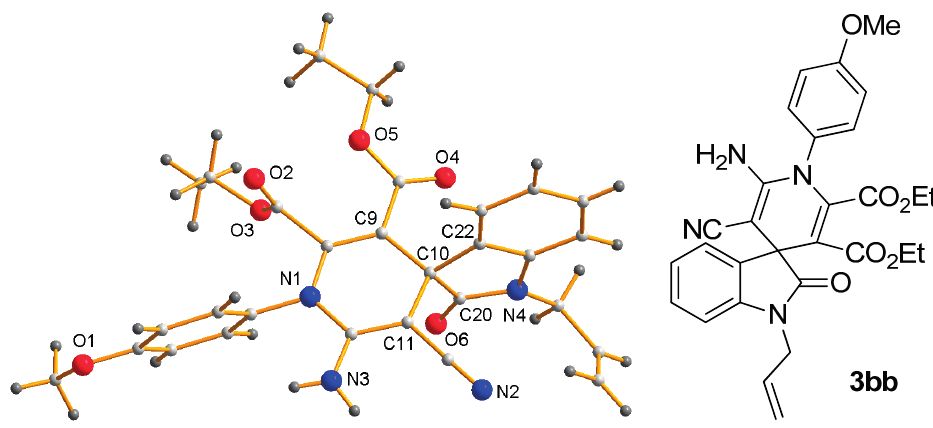
Figure 3. X-ray structure of adduct 3bb